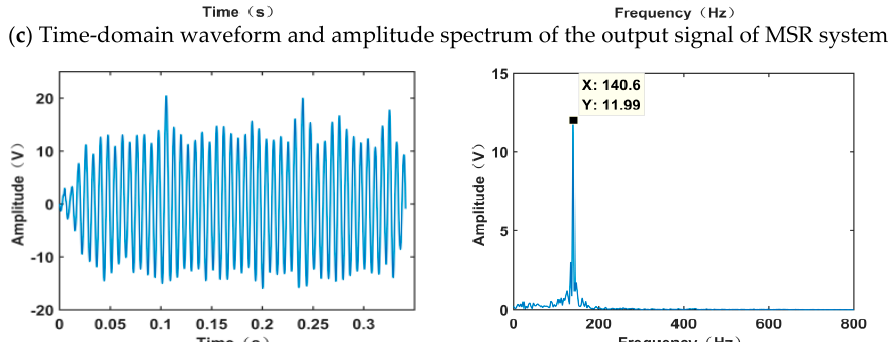
Figure 9. Rolling element signal analysis.